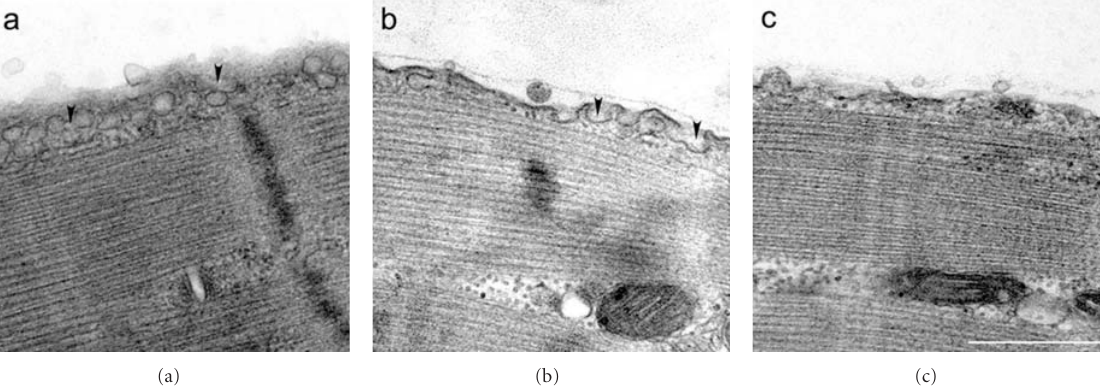
Figure 4: Cholesterol depletion destroys the morphology of caveolae. (a) In an intact FDB myofiber, there are abundantly flask-shaped caveolae that form rosettes (marked by arrowheads) beneath the sarcolemma. (b) Treatment with 1 mM CDX reduces the number of caveolae, and the morphology of individual caveolae (arrowheads) is distorted. (c) Treatment with 5mM CDX results in flattened caveolae without any distinguishable morphology. Scale bar, 500